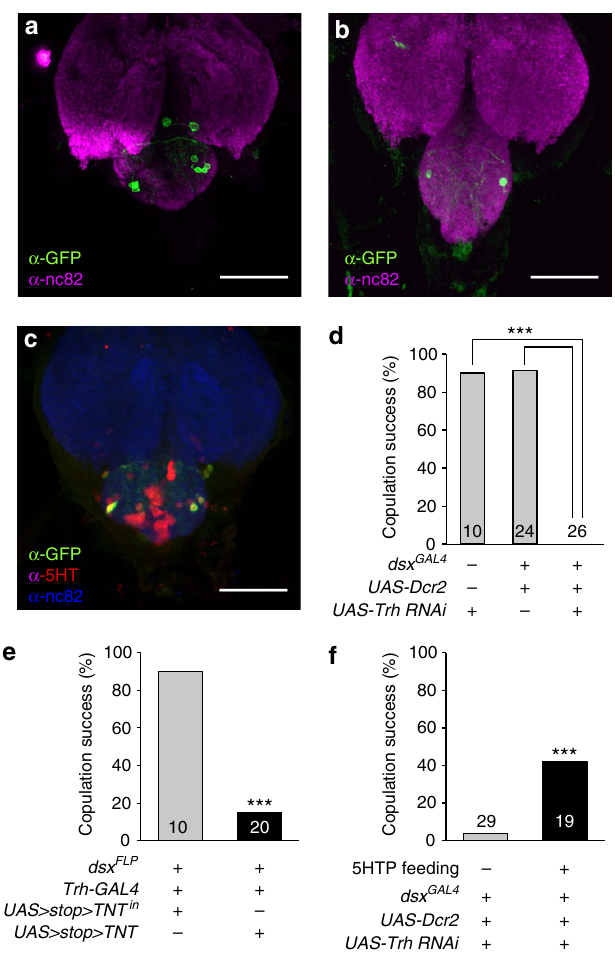
Figure 4 | Roles of serotonergic dsx neurons and 5-HT in copulation. Images of Trh-GAL4 -positive dsx neurons in the abdominal ganglion in male flies without ( a ) and with ( b ) sbb knockdown. The genotypes of flies were w; Trh-GAL4/UAS 4 stop 4 mCD8::GFP; dsx FLP / þ ( a ) and w; Trh-GAL4/UAS- sbbRNAi tubP 4 GAL80 4 ; dsx FLP /UAS 4 stop 4 mCD8::GFP ( b ), respectively. Scale bar, 50 m m. ( c ) Trh-GAL4 -positive dsx neurons are immunopositive for an anti-5-HTantibody. Scale bar, 50 m m. ( d ) Trh knockdown in dsx -positive neurons completely blocks copulation. ( e ) Block of synaptic outputs from serotonergic dsx neurons by TNT inhibits copulation. Inactive TNT ( TNT in ) has no effect. ( f ) Copulation defects are rescued by feeding adults on 5-HTP-supplemented foods. 5-HTP was administered at 100mM according to ref. 20. The mean ± s.e.m. and the number of flies examined are shown. *** P o 0.001 by the w 2